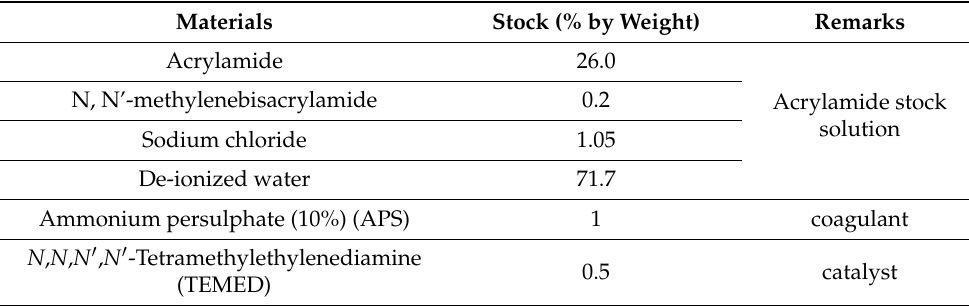
Table 3. Recipe of polyacrylamide phantom.